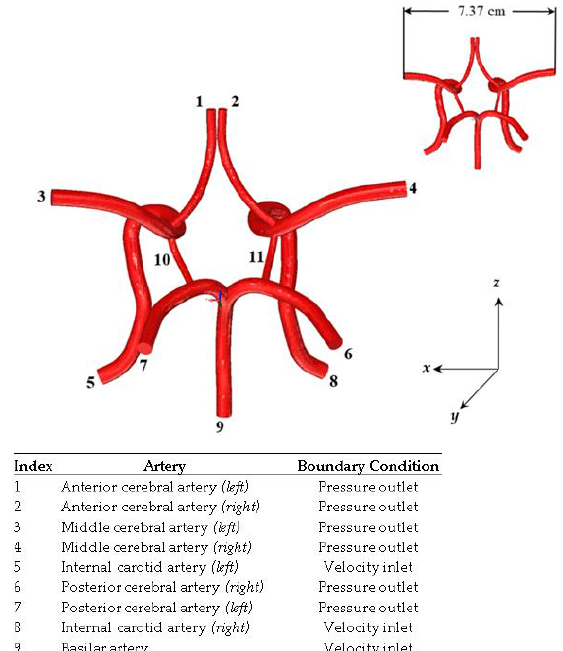
Figure 15. CAD fluid volume model of the Circle of Willis and the numbering of the inlet/outlet. This figure is cross-referenced with a table.